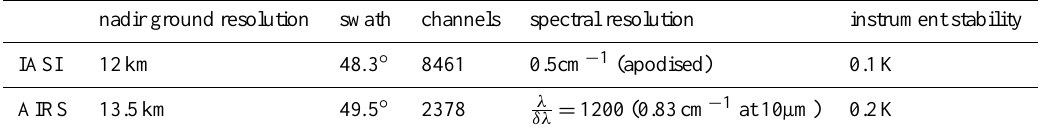
Table 1. IASI and AIRS instrument characteristics, resolutions and stability (Aumann et al., 2003; Blumstein et al., 2004; Larar et al.,